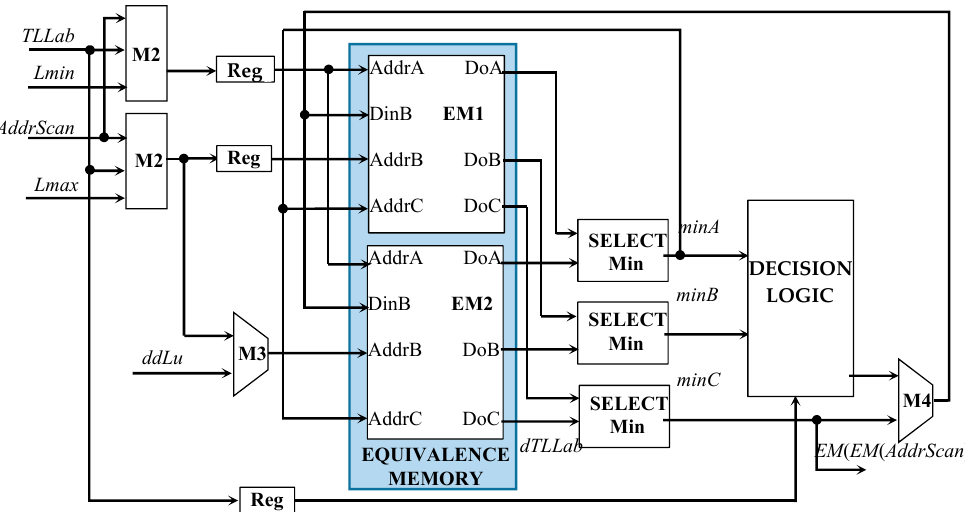
Figure 10. The hardware architecture of the equivalence memory EM.